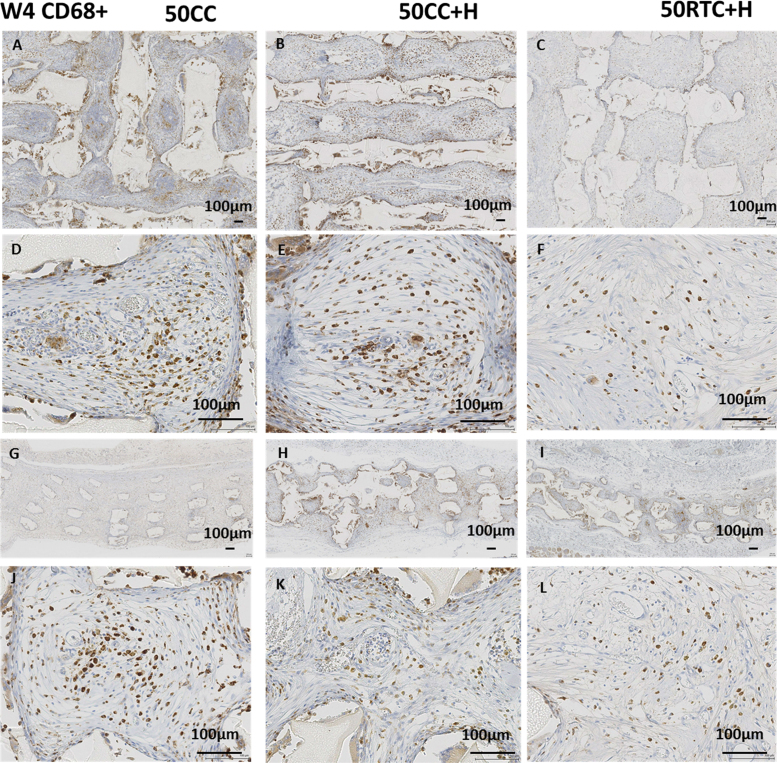
Immunohistochemistry of the host macrophage response towards scaffolds in vivo at week 4. Tissue integration of middle-in-plane (A-F) and cross-sectional view (G-L) of the scaffolds by CD68 (M1 pan-macrophage/monocyte marker) staining at (A-C, G-I) ×4 and (D-F, J-L) ×20 magnifications.